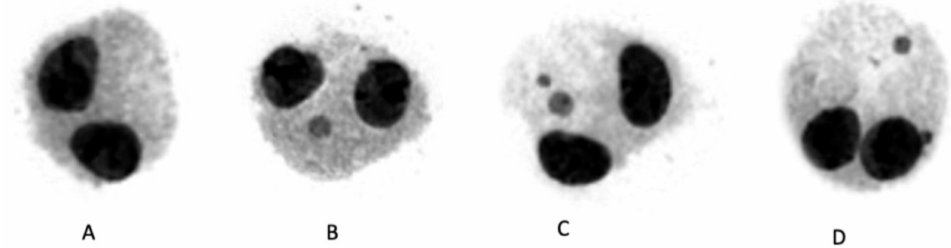
Figure 1. Representative photos of binucleated cells stained with Giemsa (Metafer system); ( A ) binucleated cell, ( B ) binucleated cell with one MN, ( C , D ) binucleated cells with two